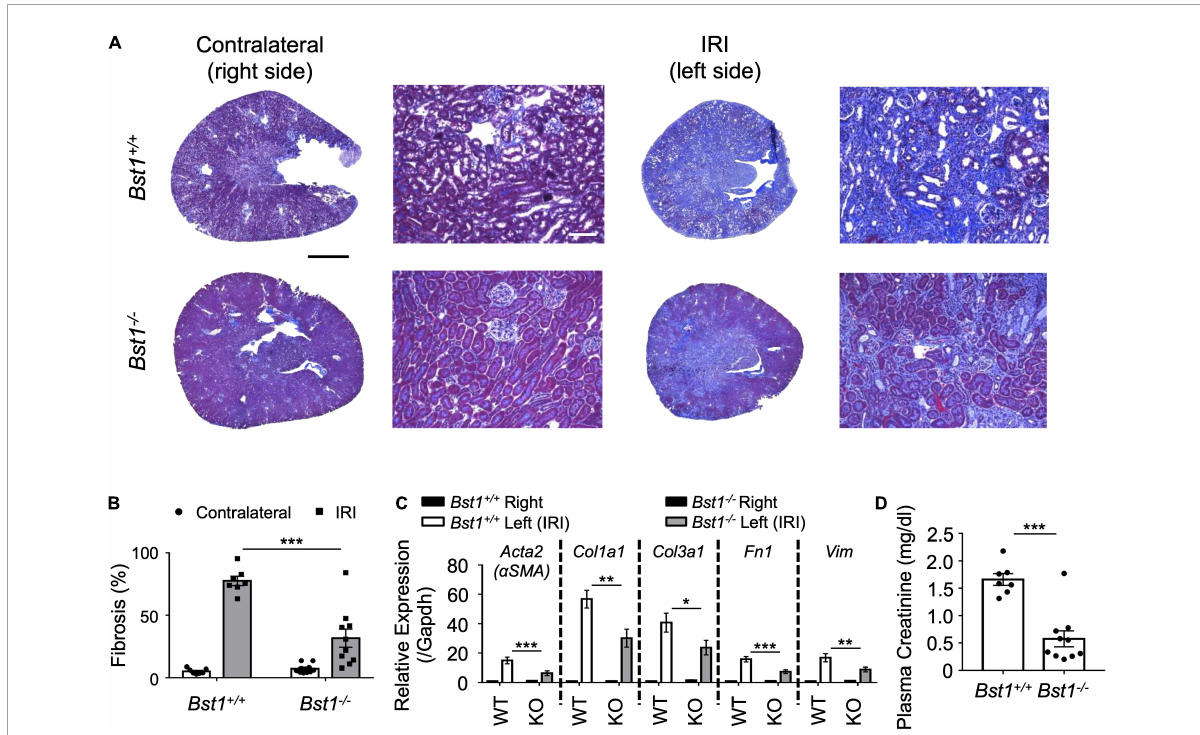
FIGURE5 Bst1 -deficient mice develop less renal fibrosis. Nephrectomy (right, unoperated kidney) was performed 13 days after renal unilateral (left, ischemic kidney) ischemia-reperfusion injury (IRI; 26 min ischemia; as in Figure 1A ). One day later the extent of kidney injury was evaluated. (A,B) Representative images and quantification of kidney sections by Masson’s trichrome staining. The fibrotic area is expressed as the percentage of the kidney tissue section surface area occupied by blue trichrome stain. Bst1 -deficient mice develop less renal fibrosis as shown by tissue morphology [ (A) representative Masson’s trichrome staining of kidney sections, (B) scored from Masson’s trichrome stained sections] and RT-PCR of fibrosis markers [ (C) RNA was isolated from whole kidney]. WT, Bst1 + / + mice; KO, Bst1 − / − mice. (D) Kidney function of the injured (fibrotic) kidney (left) was evaluated by plasma creatinine 1 day after contralateral (right) nephrectomy. Kidney function was preserved in Bst1 − / − mice after unilateral IRI. n = 7–10 in panels (B–D) . Data in panels (B,C) were analyzed with two-way ANOVA. Means were compared by post hoc multiple-comparison test (Tukey’s). Data in panel (D) were analyzed with Student’s t -test (2 tailed). * P < 0.05, ** P < 0.01 and *** P < 0.001. Scale bar = 1 mm in whole kidney and 200 µ m in inset.